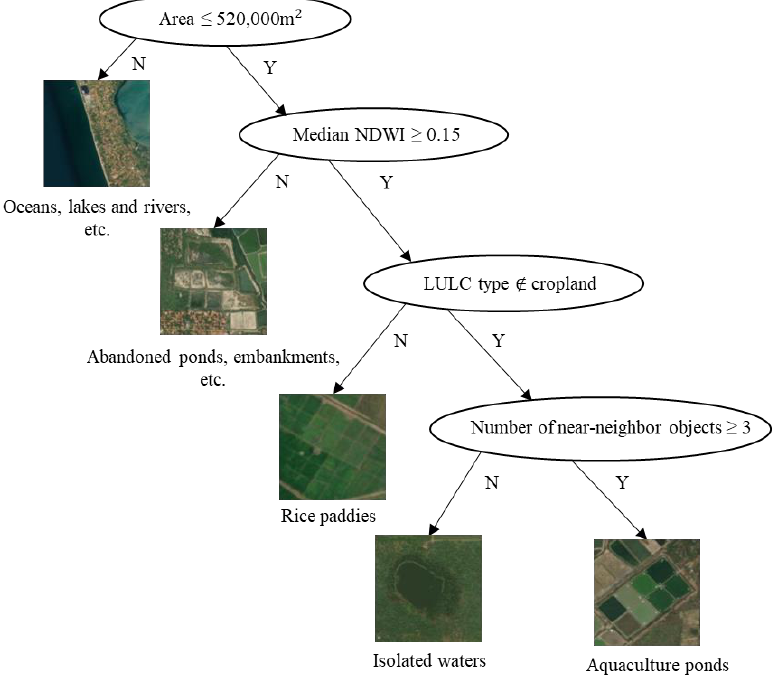
Figure 7. Decision tree for extracting aquaculture ponds from potential SOAPs (Note: Y = Yes; N = No).